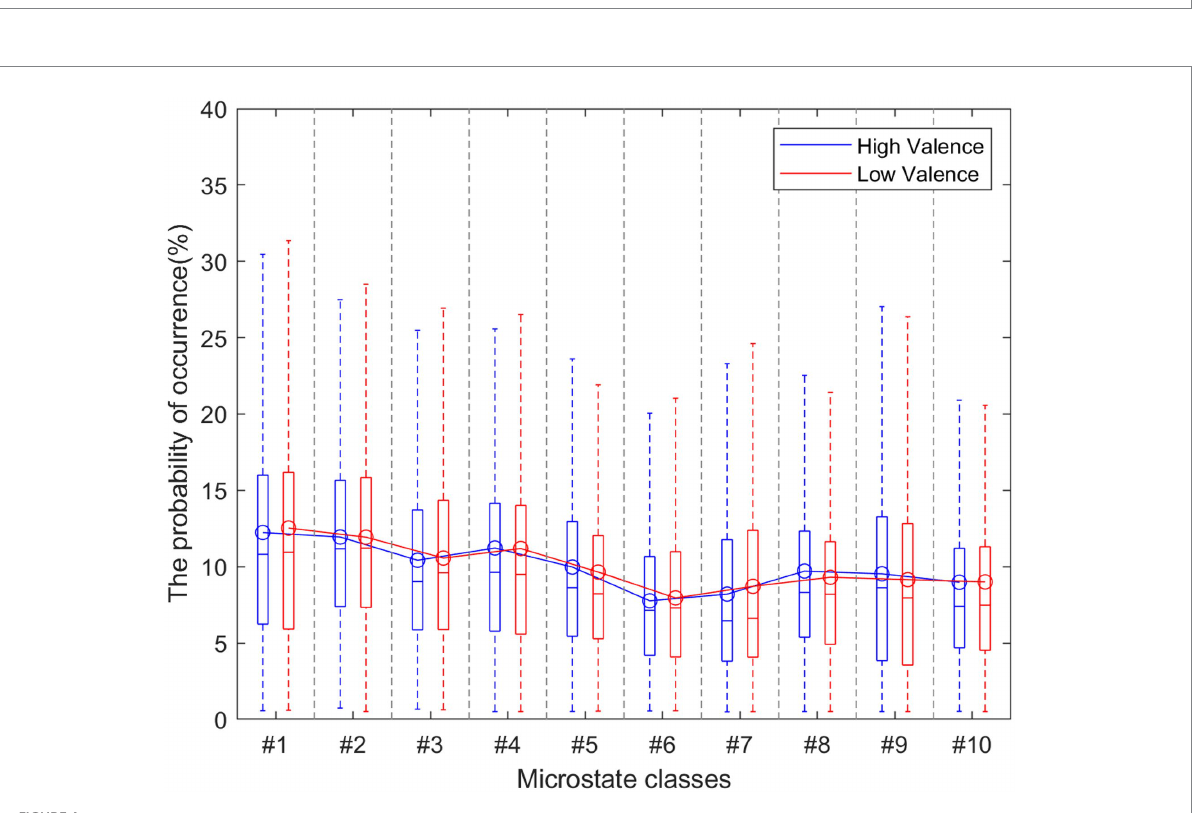
FIGURE 4 The probability of the occurrence of a specific